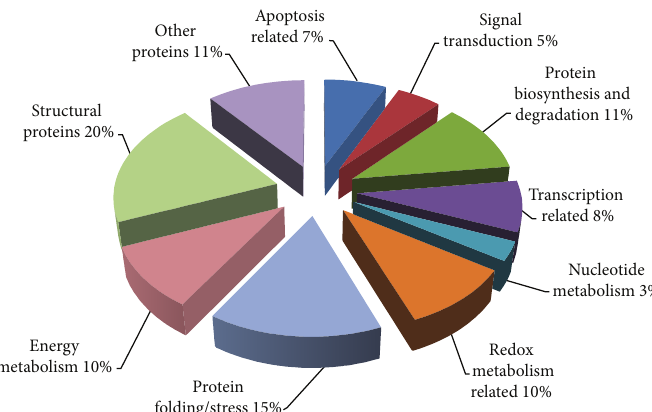
Figure 6: Classification of identified proteins based on their molecular function and their involvement in biological processes. Pie chart representing the distribution of the 61 identified proteins based on their molecular function and biological processes. Assignments were made on the basis of information from PANTHER analysis (http://www.pantherdb.org/) as well as NCBI (http://www.ncbi.nlm.nih.gov/pubmed) and Swiss-Prot/TrEMBL annotations